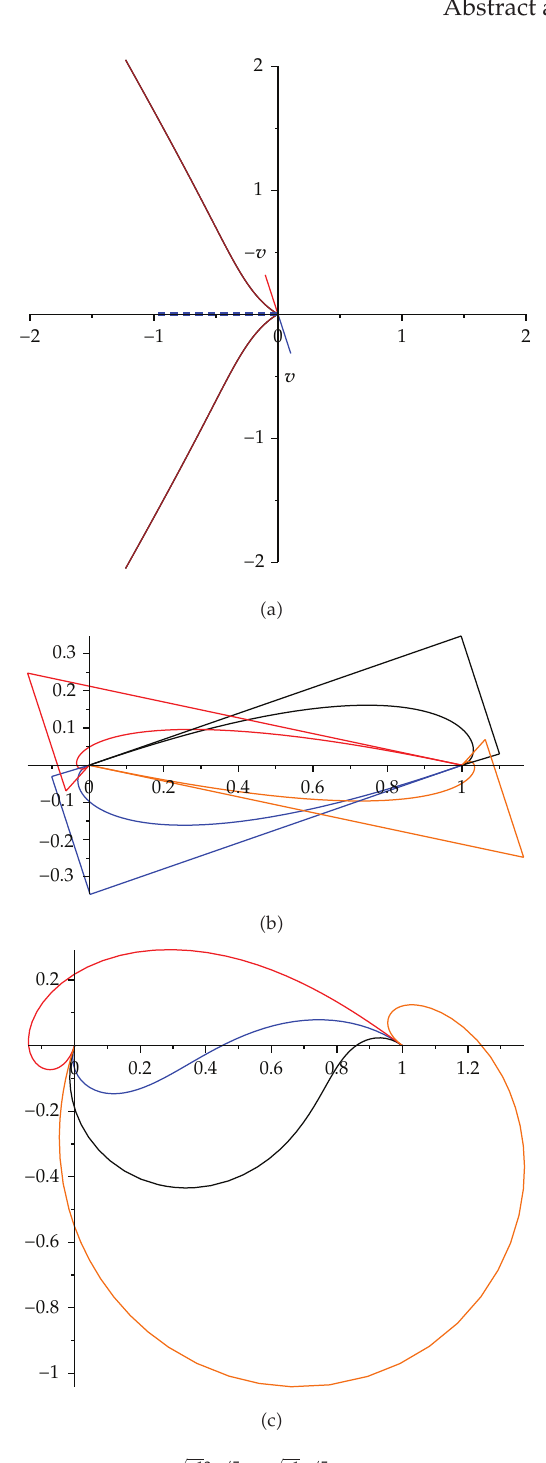
Figure 4: For the Hermite data-set (cid:2) 0 , 1 ,e − v / ∈ D ; the central graph shows the PH cubics r (cid:2) t (cid:3) with their control polygons; the graph on the right shows the four